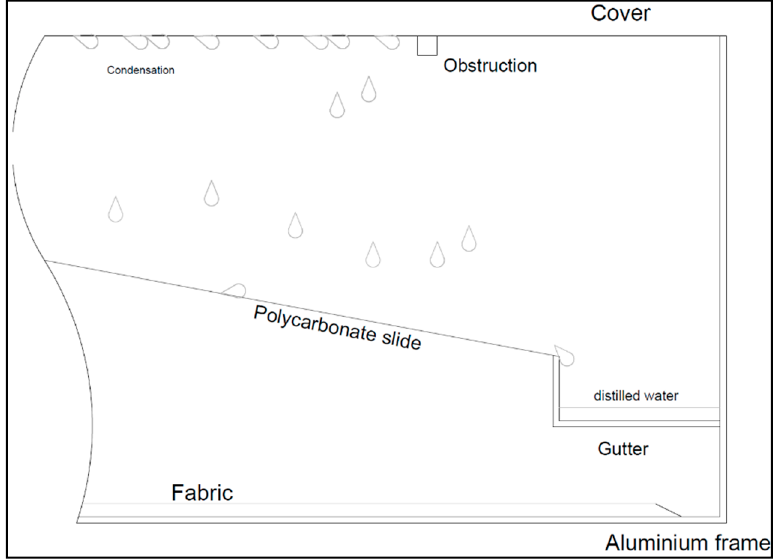
Figure 3. Cross-section (side) of the solar still panel showing the obstruction and polycarbonate sheet position.